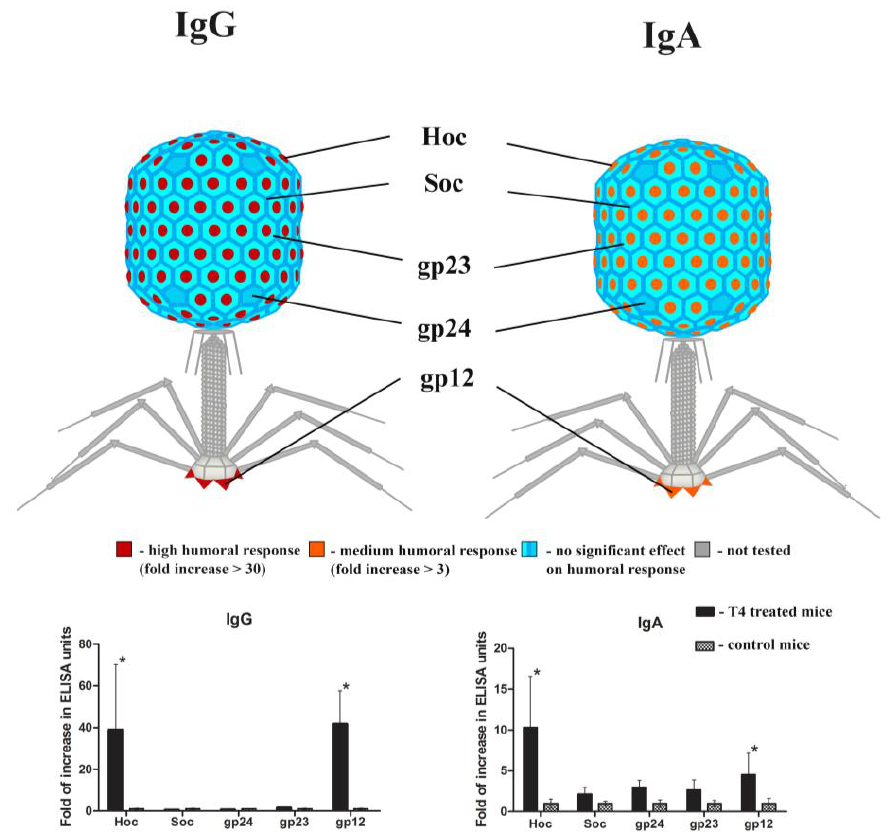
Figure 3. Individual contribution of T4 head proteins and gp12 to phage immunogenicity in mice treated with the phage per os . Mice ( N = 7) were fed with T4 phage 4 ˆ 10 9